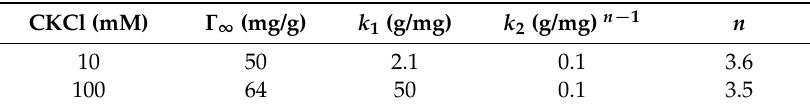
Table 1. Fit parameters for polydiallyldimethylammonium chloride (PDADMAC) adsorption